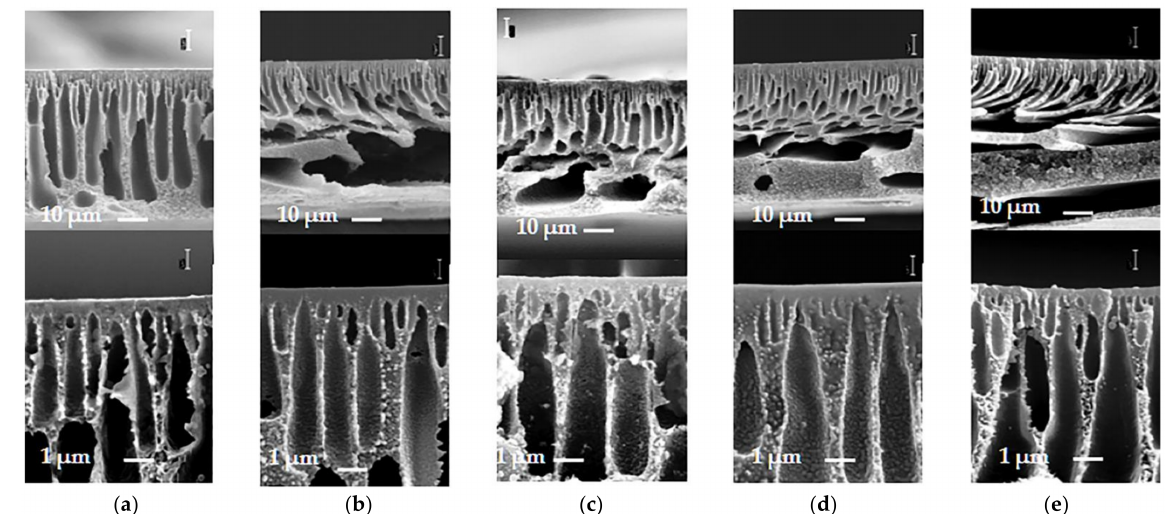
Figure 6. SEM images of the membrane cross-section and enlarged fragment of cross-section, PPSU:PSF ratio in the casting